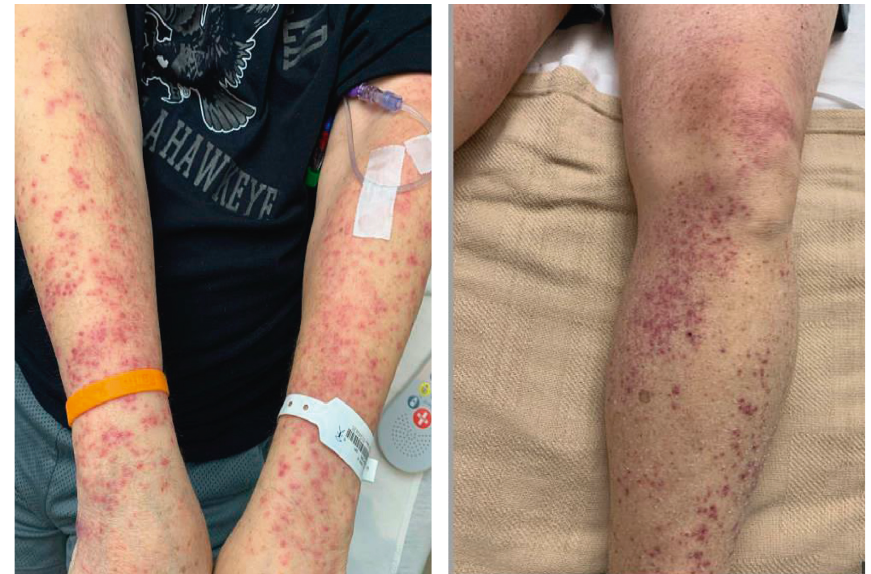
Figure 1: Maculopapular rash in the patient’s bilateral upper and lower